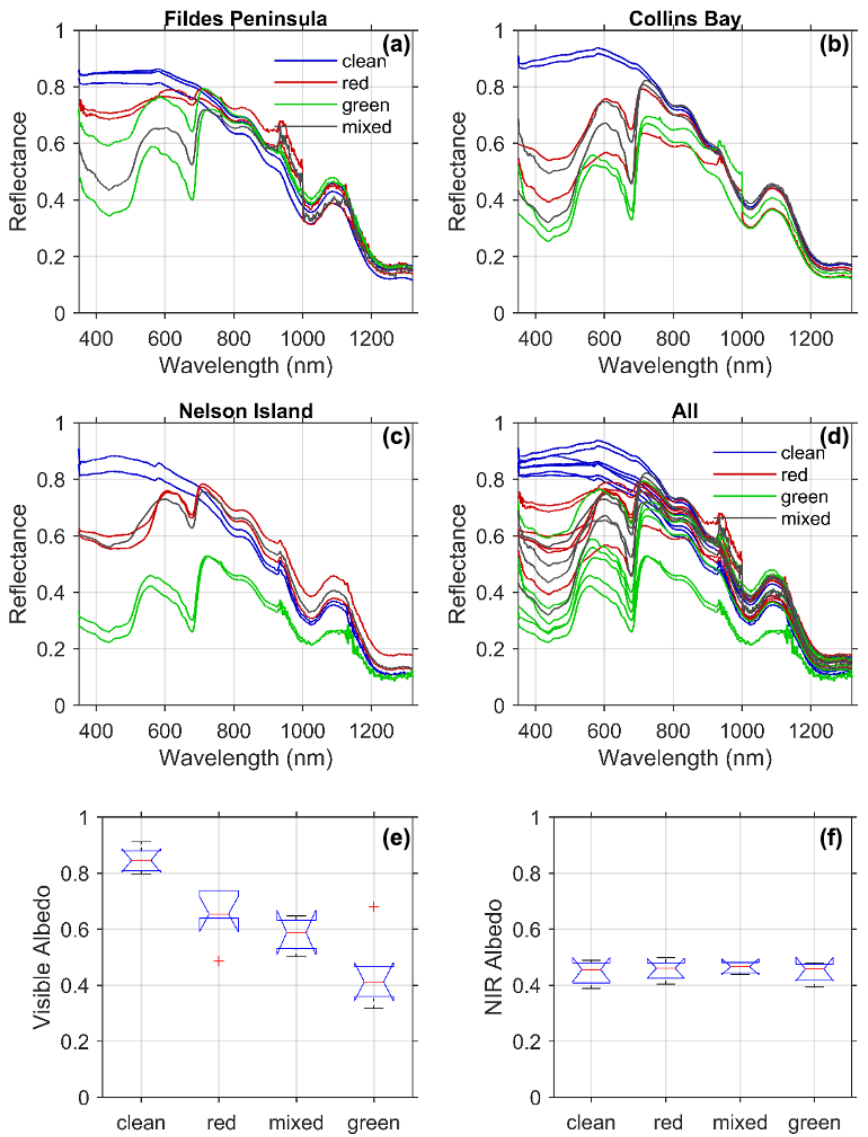
Figure 4. Spectral reflectance colored according to each type of snow algae measured at each location from Fig. 1 (a–c ) and for all the stations together (d) . Albedo was calculated following Eq. (9) for each snow type for (e) visible wavelengths (400–700nm) and (f) near- infrared wavelengths